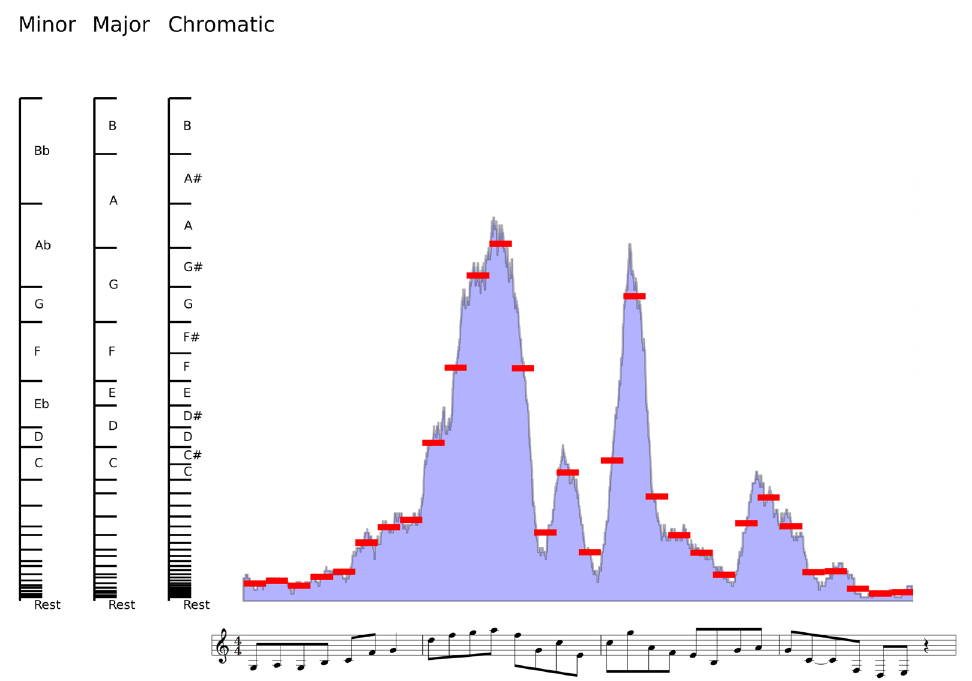
Figure 1. Graphical representation of the approach used to transform quantitative signals to music. ChIP-seq values (H3K4me3 in the example) are binned in fixed-size intervals over the genome. Each interval corresponds to a 1/8 note. Average values of log-transform of read counts in each genomic bin (red lines) are matched into predefined number of semitones (chromatic scale). Notes may be mapped to a specified scale (major and minor scales are exemplified in the figure). Consecutive equal notes are merged in single note with double duration. Values falling in the first bin are considered